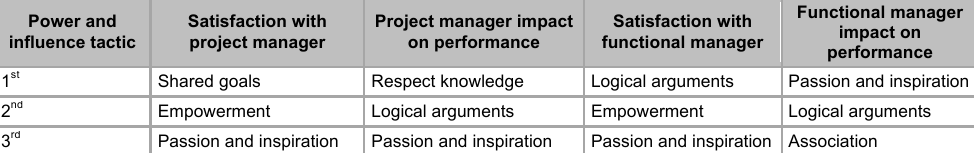
Project personnel perceptions: Highest three